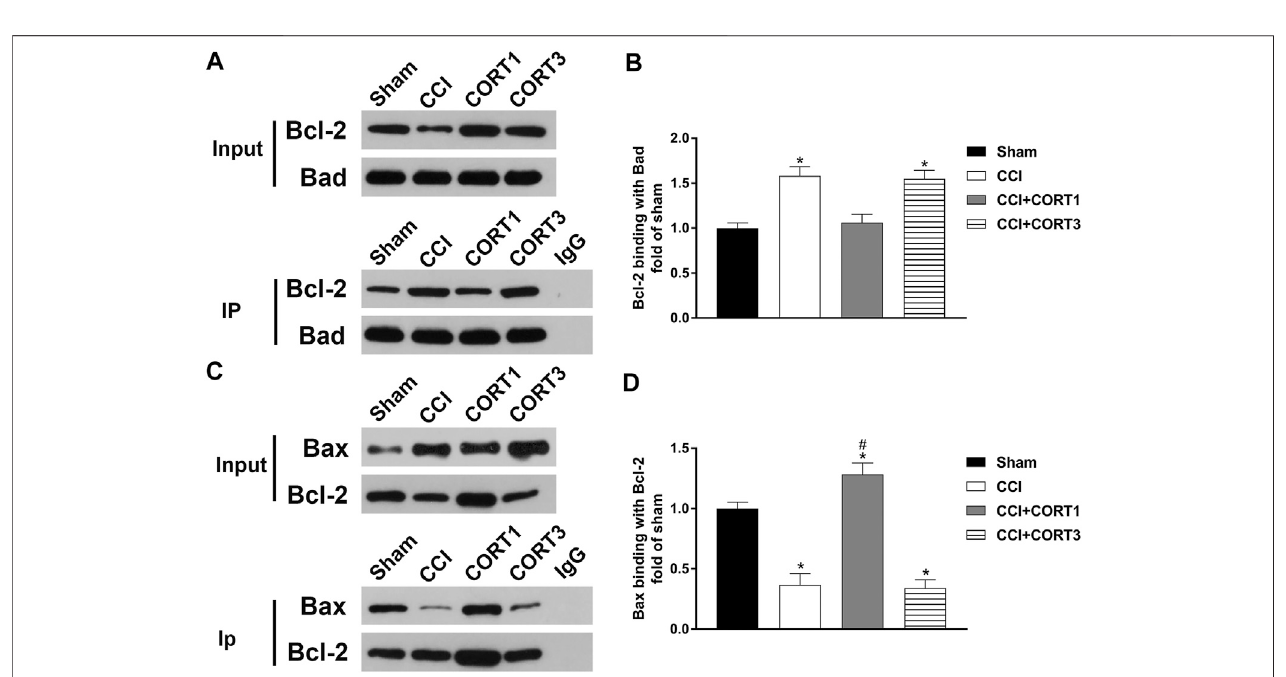
FIGURE 7 | Dose-dependent effects of CORT treatments on the interactions between Bcl-2 family proteins. (A, B) Representative western blot images and quanti fi cation of Bcl-2 levels (binding with Bad) as assessed by co-IP with a Bad antibody. (C, D) Representative western blot images and quanti fi cation of Bax levels (binding with Bcl-2) as assessed by co-IP with a Bcl-2 antibody. The concentration percentage compared to that of sham controls was calculated for each sample. * p < 0.05 compared to the sham group; # p < 0.05 versus the CCI control group. The data are presented as the mean ± SD of eight animals in each group.